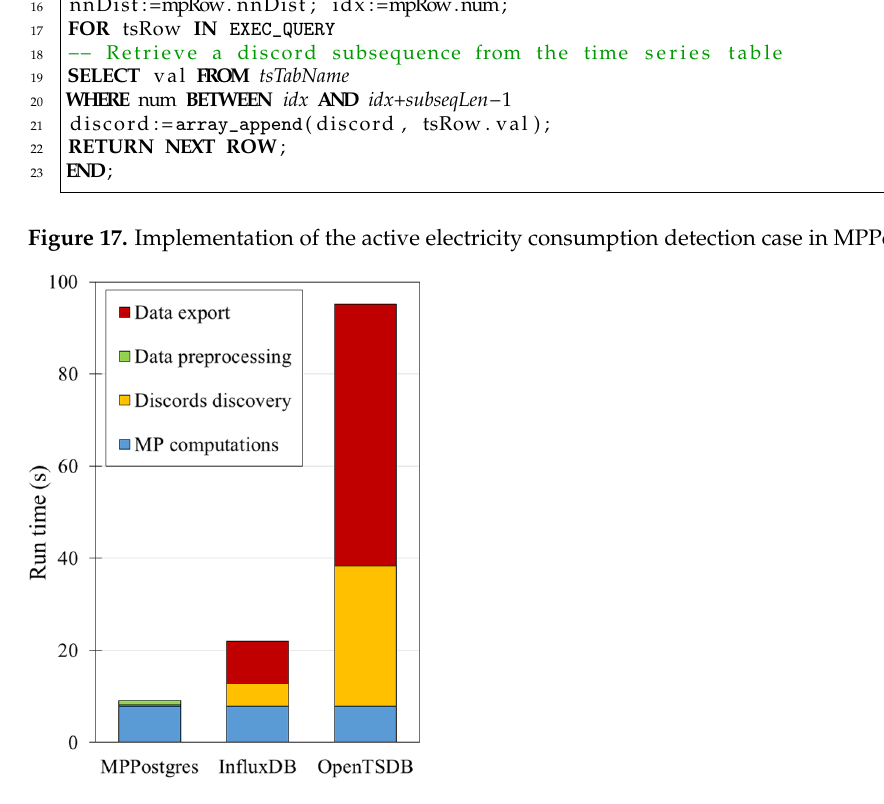
Figure 18. Performance of different TSDBMSs in the active electricity consumption detection